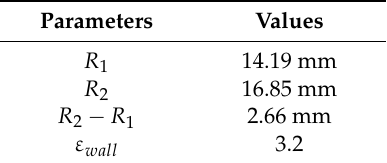
Table 8. Geometry of the pipe.